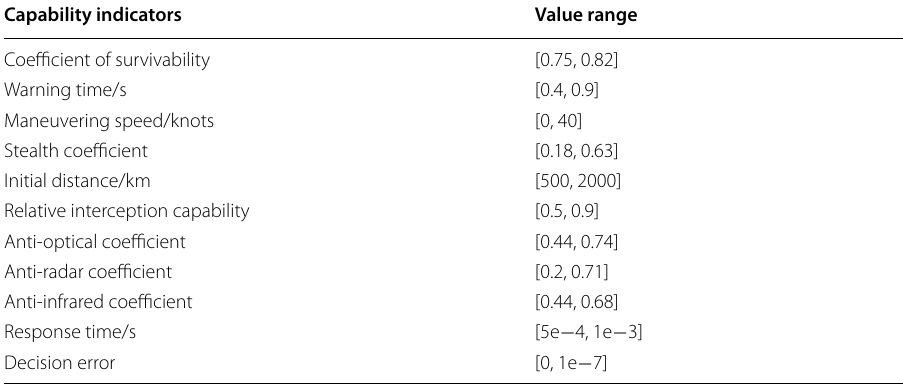
Table 1 Example table of multiple indicators of aircraft Capability